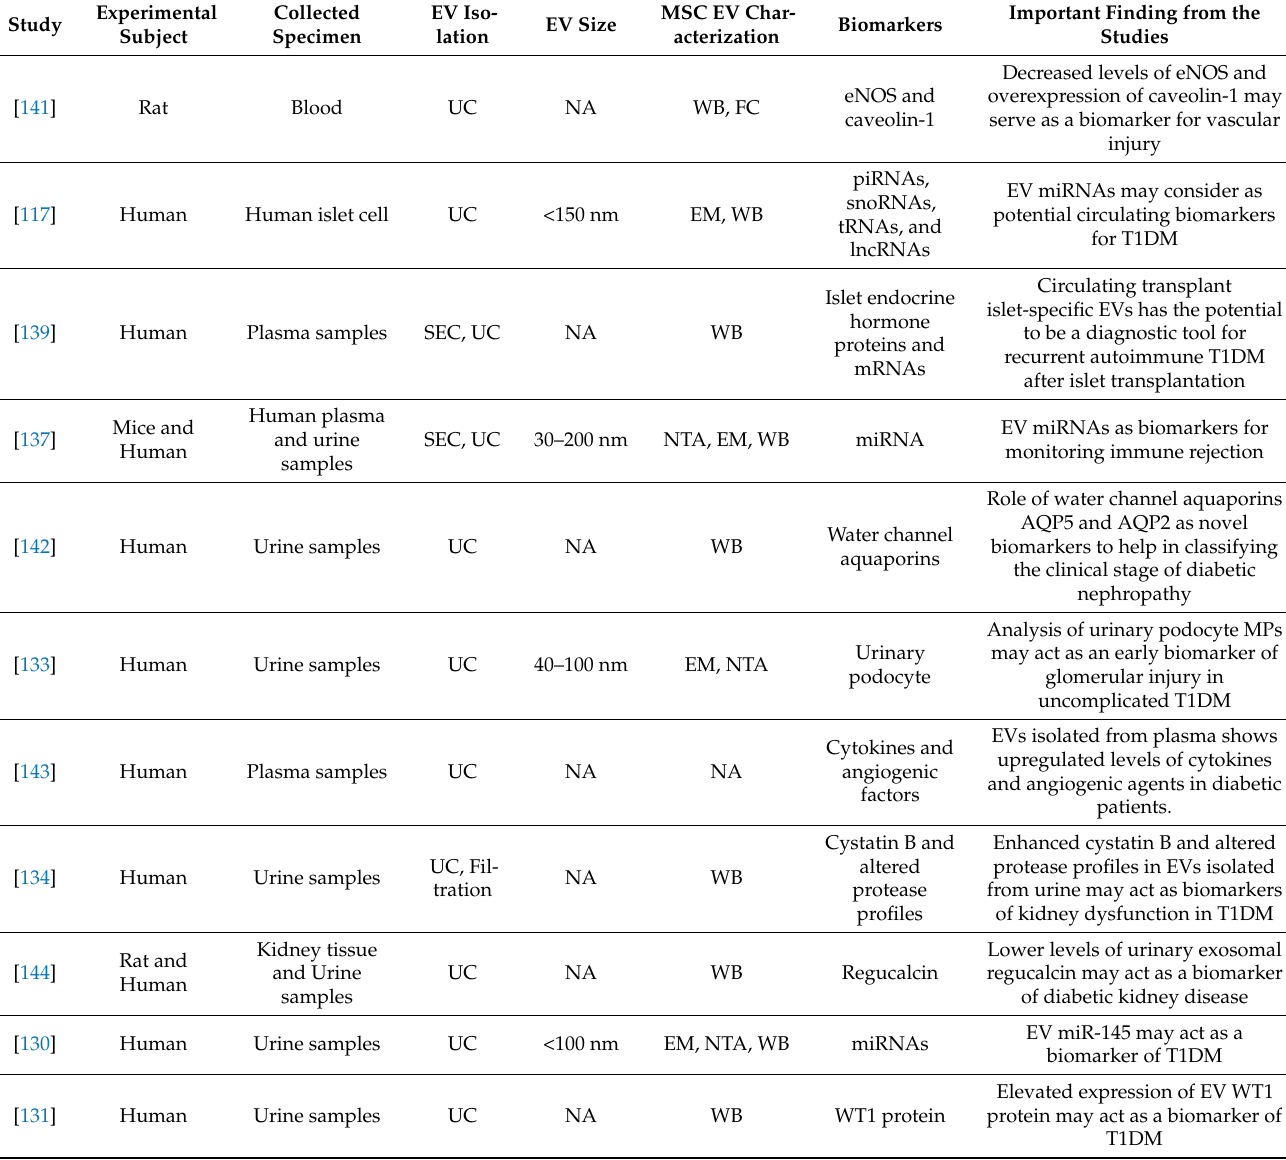
Table 4. Studies utilizing EVs as biomarkers in